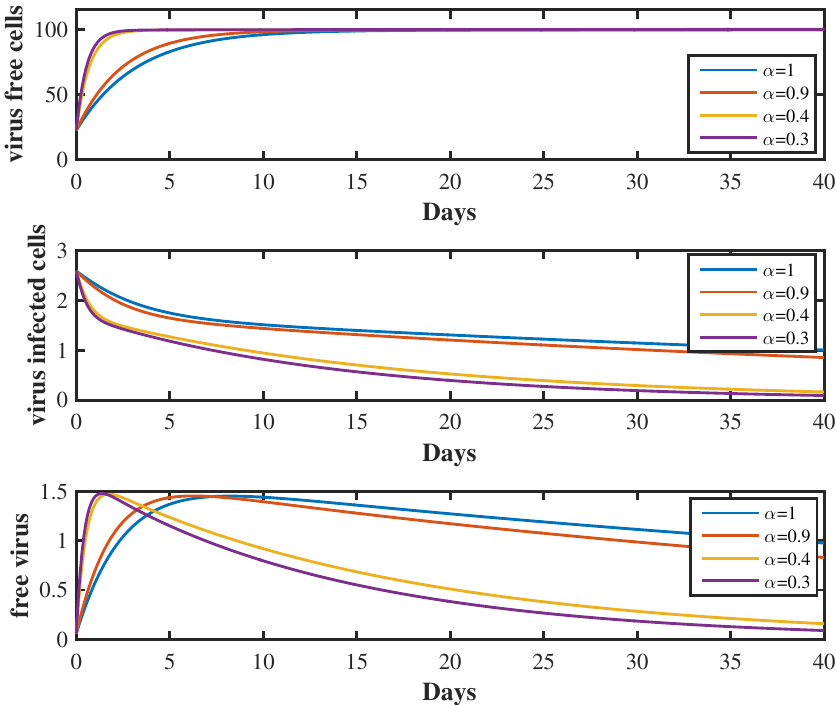
Figure 2. Numerical solution of the model (2) under different α values.